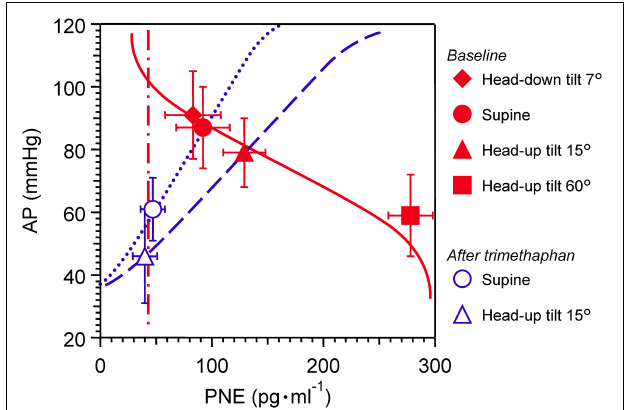
FIGURE 2 | Graph showing effects of postural tilting on arterial pressure (AP), and plasma norepinephrine level (PNE) during baseline and after trimethaphan infusion. Note that a reference level for AP measurement was not the heart but the clavicle; because the controlled or feedback variable of arterial baroreflex should be AP sensed by arterial baroreceptors localized in the wall of the aortic arch and carotid sinus. Values are means ± SD. See text and Table 1 for detailed explanation.